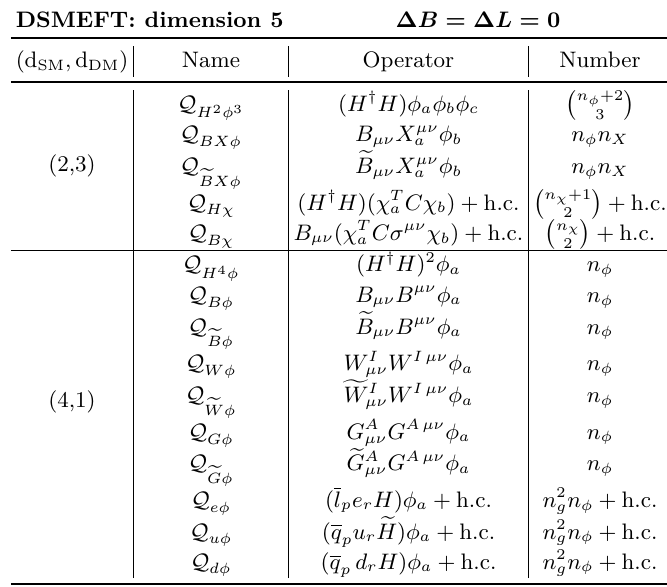
Table 10 . Dimension-five ∆ B = ∆ L = 0 operators in DSMEFT. The first column gives the dimensions of the SM and DM part of the operator, and the fourth column is the number of operators.